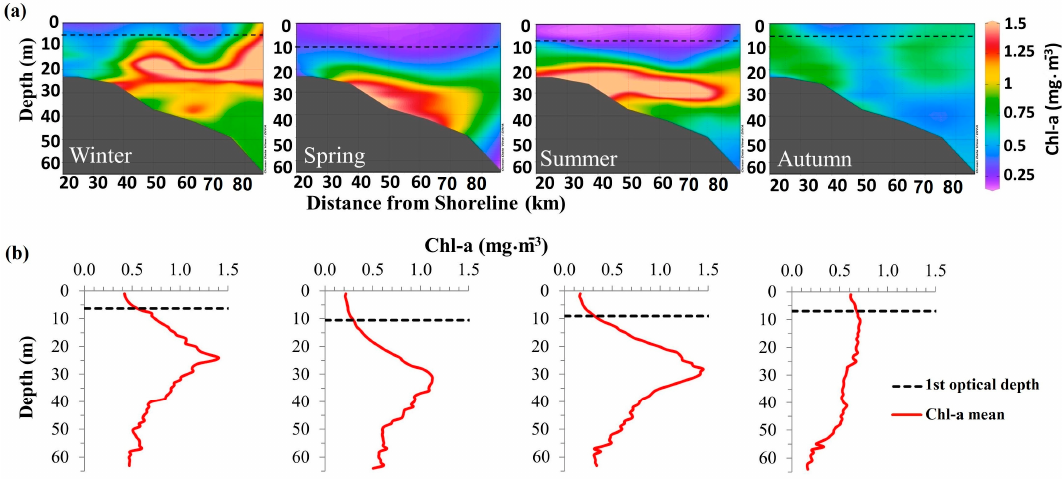
Figure 4. Vertical profiles of in situ Chl -a averaged measurements during four seasons. ( a ) Vertical profile of Chl -a along the transects in winter, spring, summer and autumn seasons (plotted using Ocean Data View (ODV) Version 4.7). The dashed line represents the first optical Depth (this is an approximate indication of how far the satellite signal penetrates into the water column). ( b ) Vertical Chl -a profiles. Red line represents mean Chl -a Averaged over 24 stations (Figure 1)/season.